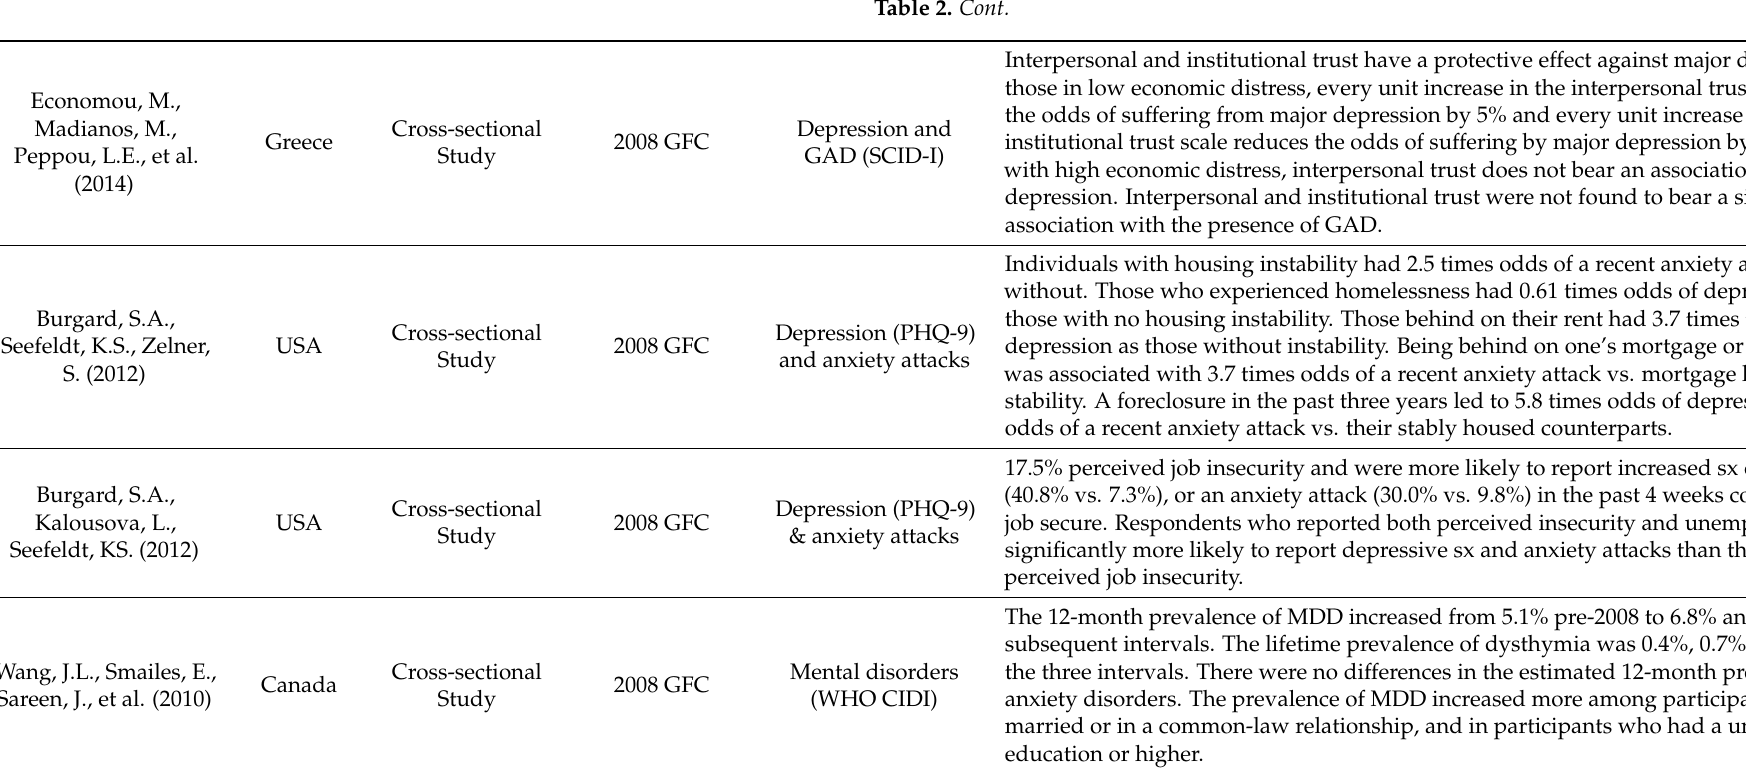
Abbreviations in Table 2: Center for Epidemiologic Studies Depression Scale (CES-D); Composite International Diagnostic Interview (CIDI); Diagnostic and Statistics Manual (DSM); Generalized Anxiety Disorder (GAD); Generalized Anxiety Disorder 7-item Scale (GAD-7); Geriatric Depression Scale (GDS); Global Financial Crisis (GFC); Hospital Anxiety and Depression Scale (HADS); International